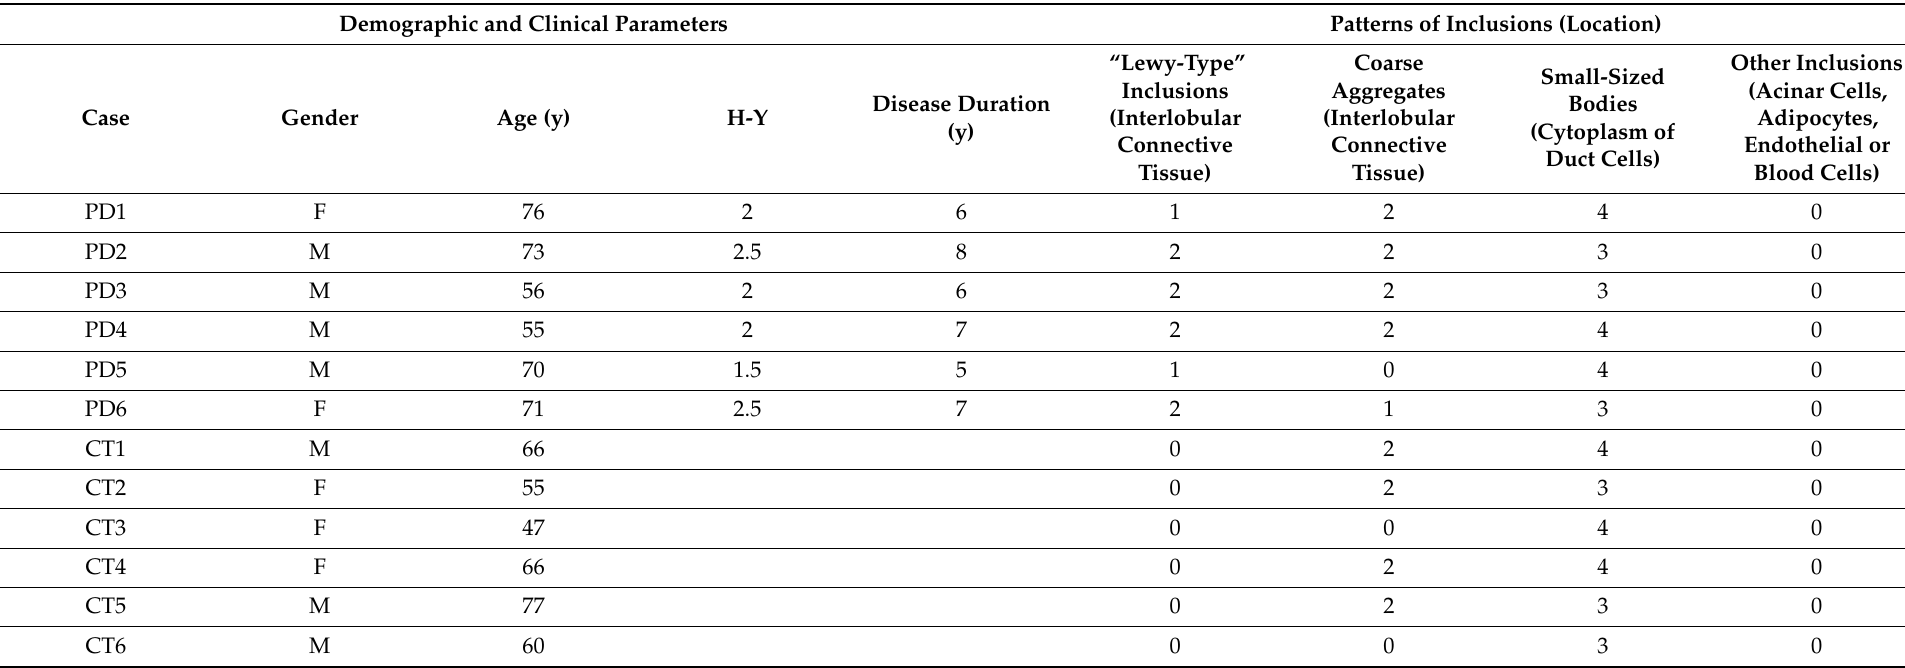
Table 3. Demographic, clinical and neuropathological data from all cases studied with idiopathic PD and control participants. Demographic and Clinical